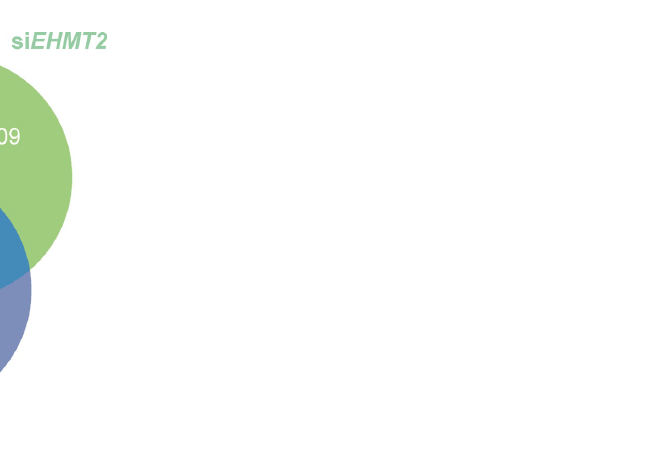
Figure 5. RT-qPCR validation of the changes in expression of the genes analysed for the binding of histone methyltrans- ferases. The figure shows that ZNF518B actually inhibits the expression of these genes . ( A ) Changes in expression in HCT116 cells caused by the knocking down of ZNF518B . ( B ) Changes in expression in RKO cells caused by overex- pressing ZNF518B . **, p < 0.01; ***, p < 0.001; NS, non-significant. 2.6. Recruitment of Inhibitory Histone Methyltransferases by ZNF518B The rationale to check the second possible mechanism to explain the oncogenicity of ZNF518B (see above) was that, if any of the selected genes is inhibited by the recruitment of EZH2 or G9A by ZNF518B, the silencing of the gene would result in a decrease of the binding of the methyltransferase over the gene and, consequently, would result in a di- minished presence of the repressive mark on the neighbouring nucleosomes (Figure 6A). For ChIP analyses, chromatin was immunoprecipitated either with anti-EZH2 or anti-G9A, and the resulting DNA was amplified with primers, which define amplicons of 100–150 bp (see Materials and Methods). These amplicons were located either at the promoter or the control regions, as annotated in the Ensembl database (Supplementary Figure S5). Many of these regions actually bind zinc-finger factors and, therefore, it is reasonable to think that these sequences may also be targets for ZNF518B. The results obtained with the antibody against EZH2 are given in Figure 7A. The PADI3 gene was not included in the study because the in silico analysis revealed that its expression was not altered by EZH2 silencing. Therefore, the results shown in Figure 7A refer to 11 ge- nomic regions, namely, the promoters of KAT2B , EFNA5 and ZDHHC2 , the first exon of EFNA5 and seven control sequences: three from RGS4 , two from EFNA5 and one from KAT2B and ZDHHC2. Barski et al. [37] showed that the repressive mark H3K27me3 extends all over the silenced genes, although it peaks in the neighbourhood of the transcription start site. To check whether this circumstance also occurred in our experiments, we included in our analysis a region from the 3’ flank of one of the genes, namely EFNA5. In 7 out of the 11 regions analysed, 4 of EFNA5 , 2 of KAT2B and 1 of RGS4 , the silencing of ZNF518B re- sulted in a significant reduction, or even in a non-detectable binding of EZH2. This sug- gests that the histone methyltransferase was recruited to these regions by ZNF518B. In other two cases, namely, the two of the RGS4 control regions, the ChIP assay showed that